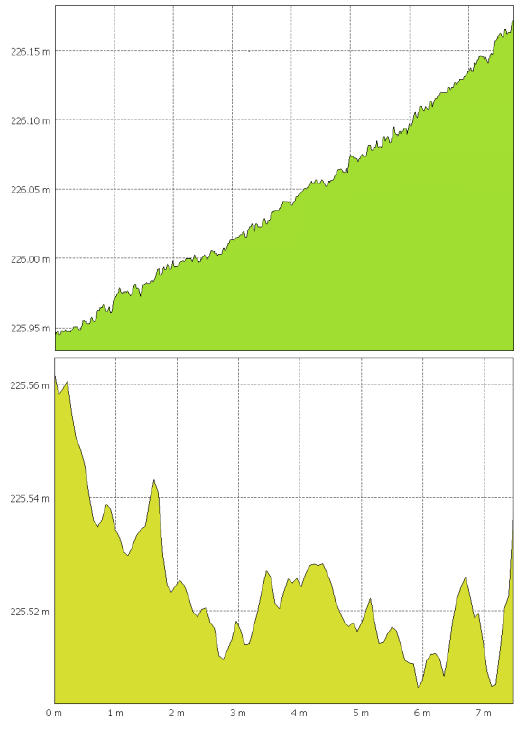
Figure 4 . RGB DEM profile and TIR DEM